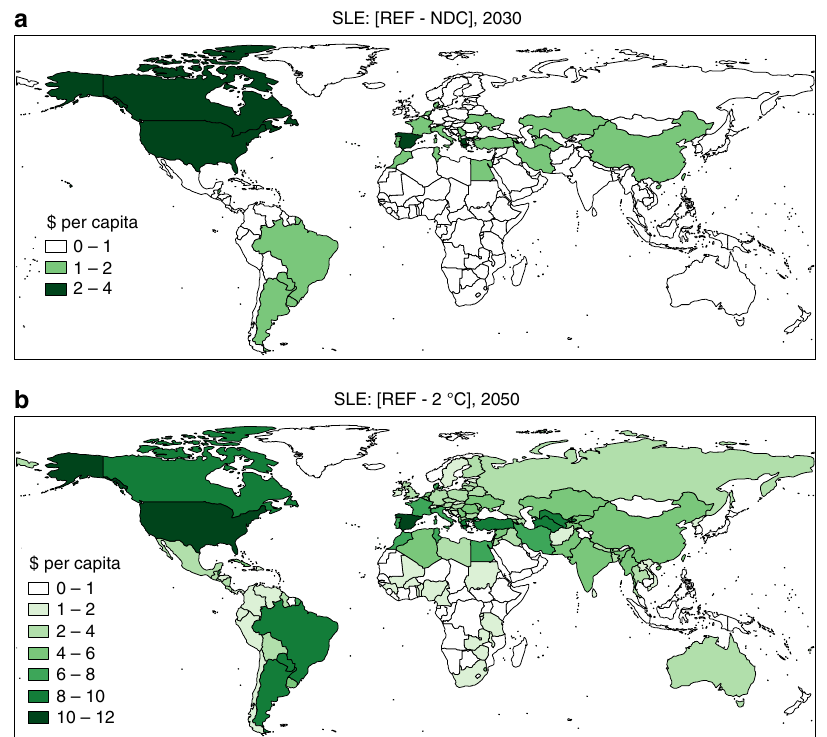
Fig. 5 Ozone-related crop yield bene fi ts due to climate policy in constant 2004 – 2006 dollars per capita. Results are shown for the case of Stringent Legislation (SLE) for air pollution. a Difference between the Reference (REF) and the NDC scenario in 2030. b Difference between the Reference and the 2 °C scenario in 2050. Valuation obtained by applying future crop productivity improvements compared to the Reference on the average gross production value of 2009 – 2013 and dividing by the population average of the same